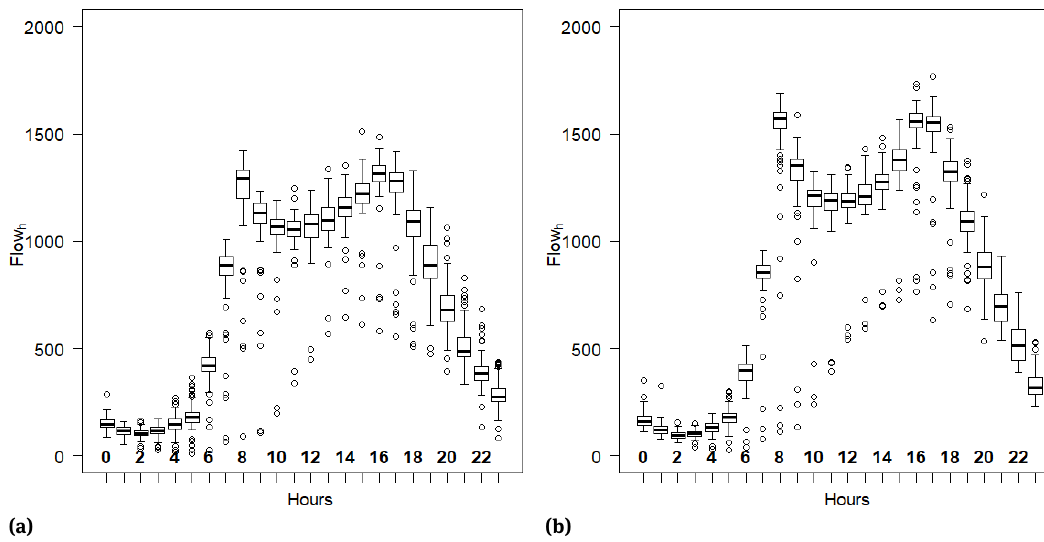
Figure 5: The annual hourly traflc flow box plots for all vehicle sets for period of 24h at business days: a) in 2012, b) in 2016